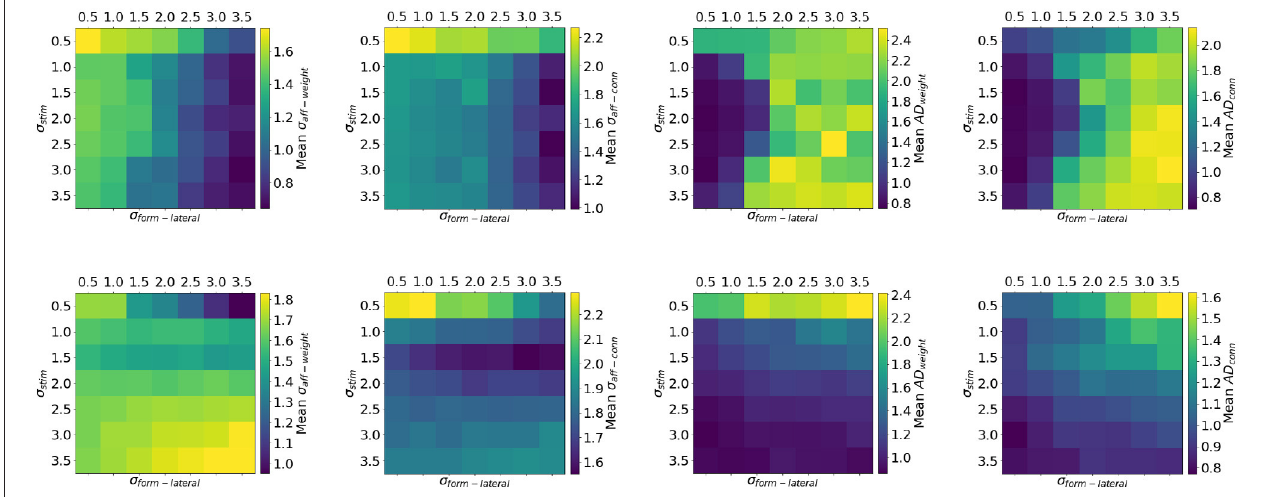
FIGURE 10 | Quality of topographic maps when varying the spread of the stimulus σ stim and σ form − lat (experimental setup of Case 1). The top row shows results from simulations wherein lateral connections are excitatory, while in the bottom row lateral connections were inhibitory. When lateral connections are inhibitory the network is less sensitive to the choice of σ form − lat compared to having excitatory connections. Moreover, lateral inhibition stabilizes the